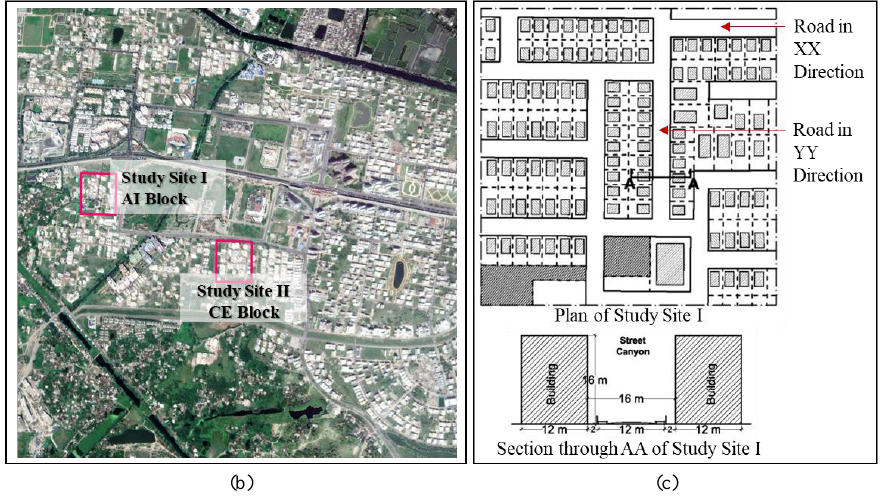
Fig. 1. (a) Location and details of study area, (b) Satellite image of study sites, (c) Schematic plan and section of Study Site I. The Rajarhat Newtown (22.35° N 88.28° E) of North 24 Parganas district is a growing planned city in the eastern Kolkata Metropolitan Area, 10 km away from the centre of Kolkata. It comes under tropical wet and dry climate (Aw) according to Koppen’s climate classification and referred as warm humid climate zone according to the National Building Code of India, with annual maximum temperature 44 °C in April and as low as 7.2 °C in December. Average annual rainfall is 1800 mm occurring mostly in the months from June to September. Highest average relative humidity is 83 % in July–August and lowest is 58 % in February–March. Major wind flow is from south during summer and the average speed varies between 0–4 m/s [23]. Two neighbourhoods of the Rajarhat Newtown Action Area I, are selected for the present study with street canyons running in both E-W and N-S direction. The study sites are marked with dotted outlines in Fig. 1(b). Though the two study sites are studied and all the simulations are run for both the sites,